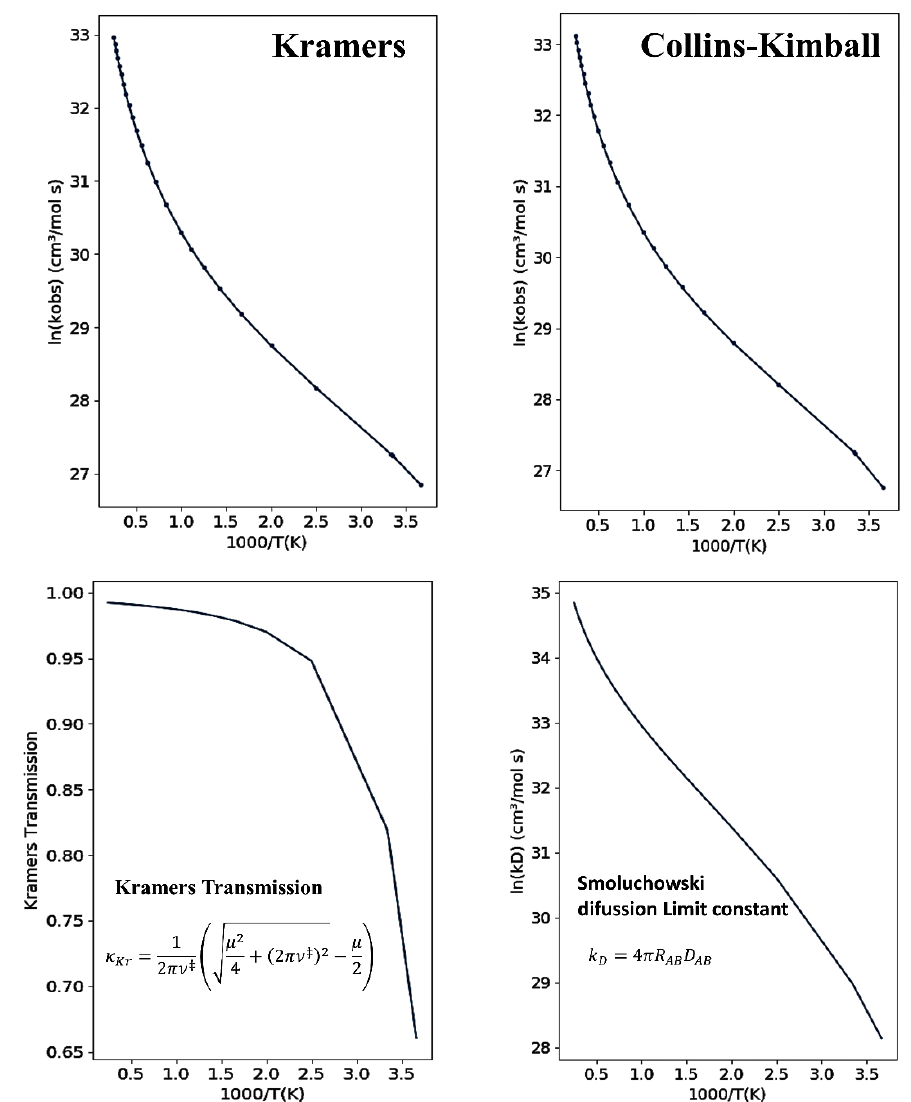
Figure 5. Upper panels present the Arrhenius plots as given by the program for the NH 3 + OH → NH 2 + H + H 2 O reaction using Kramers’ and Collins– Kimball formulations. The lower panels show the 2 O reaction using Kramers’ and Collins–Kimball formulations. The lower panels show the Kramers Kramers transmission and Smoluchowski diffusion limit constant as a function of inverse transmission and Smoluchowski di ff usion limit constant as a function of inverse temperature.